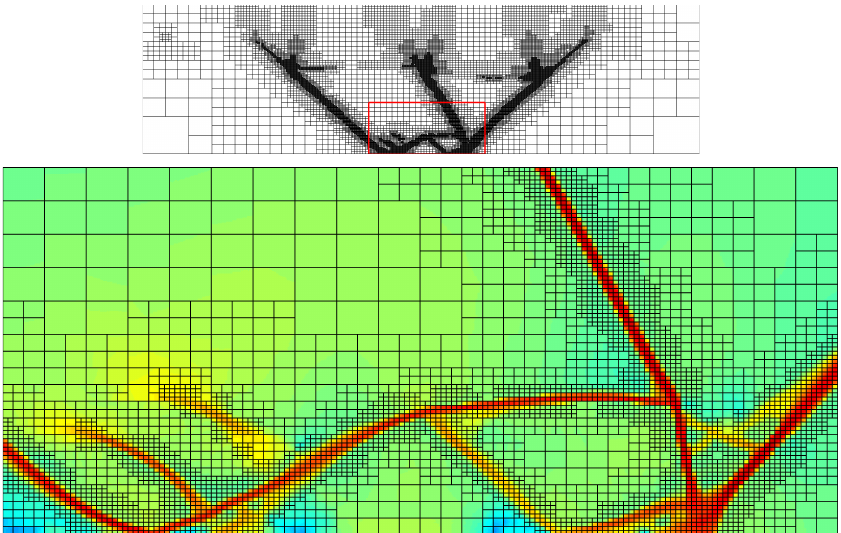
Figure 26. Results of adaptive extension simulation with φ = 0 ◦ after 25.33% strain. Top: numerical grid; bottom: zoom as marked by a red rectangle here and on Figure